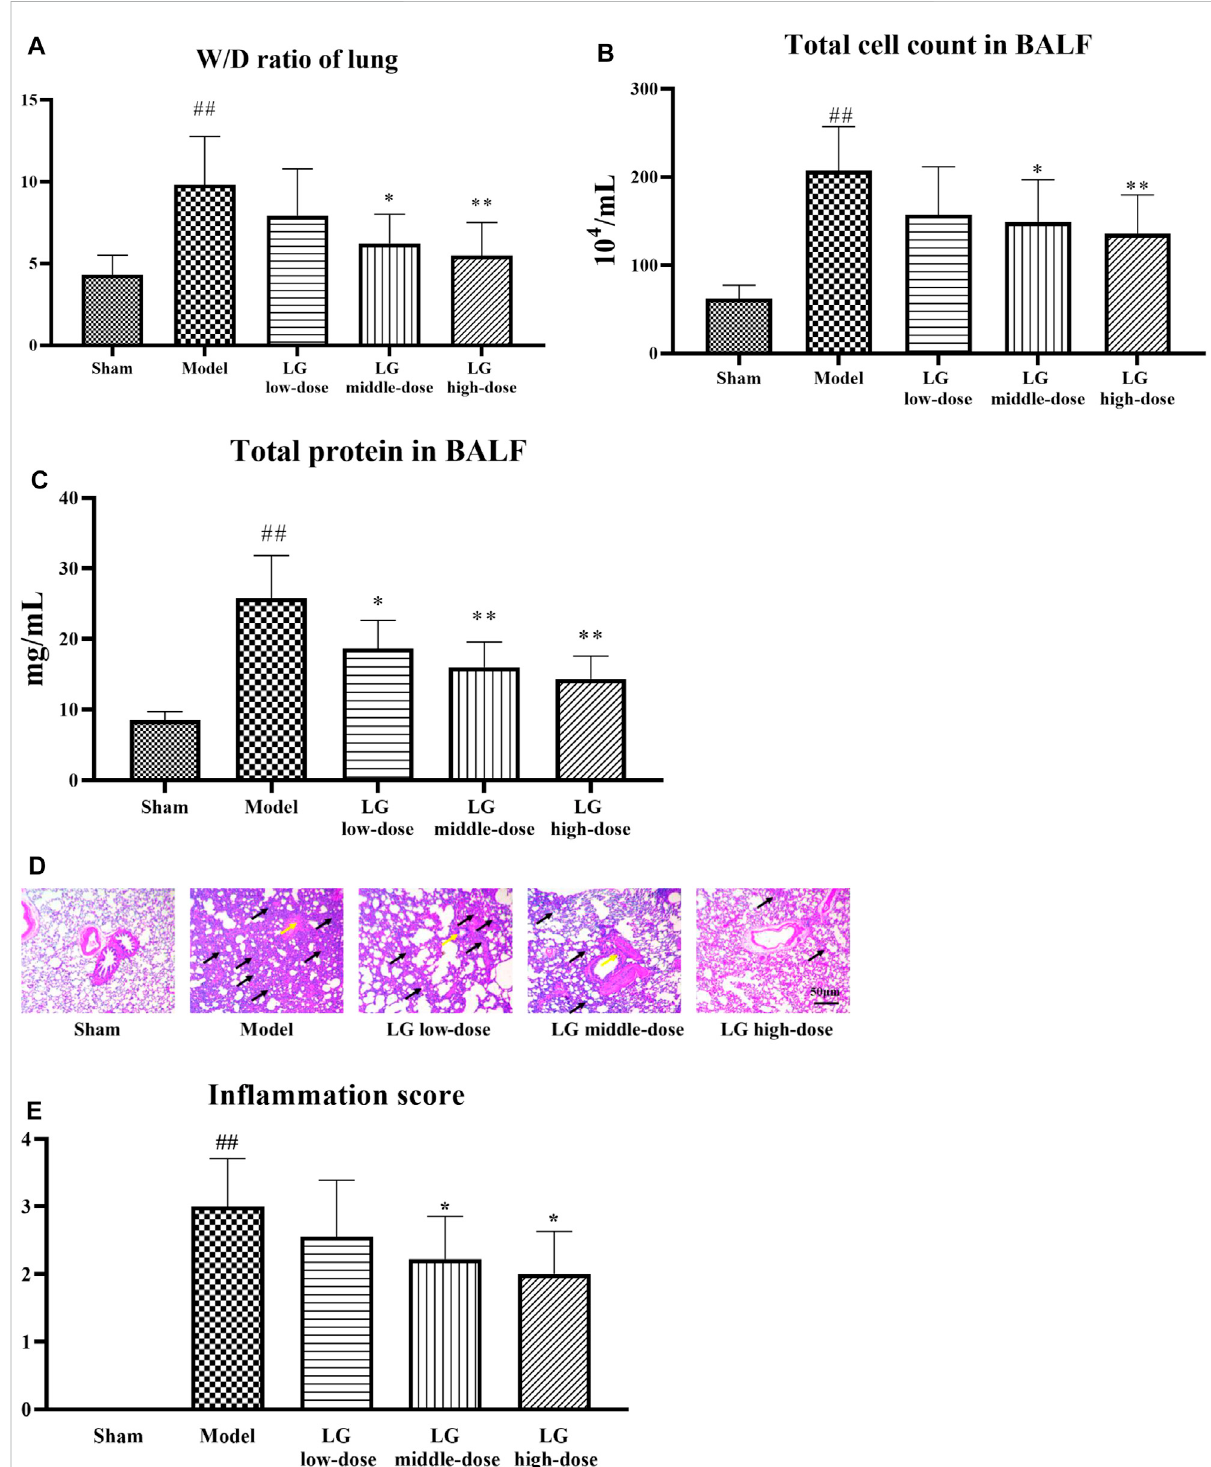
FIGURE 2 LG treatment alleviated acute lung injury in septic model rats. (A) LG decreased the W/D ratio in lung. (B) LG treatment decreased the total cell count in BALF. (C) LG treatment decreased the total protein concentration in BALF. (D,E) HE staining indicated that LG treatment alleviated the pathological changes and decreased the in fl ammation score in lung (100×), black arrows indicated in in fi ltratiion of in fl ammatory cells and yellow arrows indicated the damage of bronchial structure. W/D: wet/dry, HE: hematoxylin and eosin. Sham group (n = 15), Model group (n = 8), LG low-dose group (n = 9), LG middle-dose group (n = 9), LG high-dose group (n = 10) ##: p < 0.01 compared with the sham group; *: p < 0.05 compared with the model group; **: p < 0.01 compared with the model